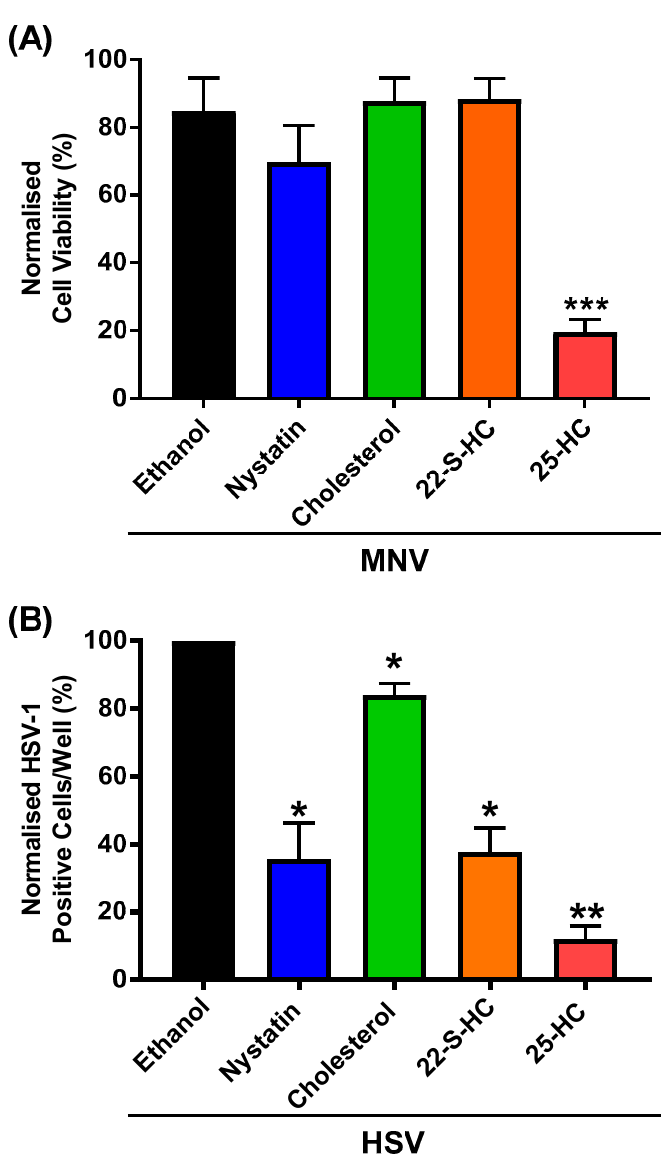
Figure 5. The effect of 25-HC is oxysterol-specific. ( A ) RAW264.7 cells were infected with MNV at 0.05 TCID50/cell in the presence of 25-HC, 22-S-HC, cholesterol (all 6.6 µ M), nystatin (50 µ M) or ethanol-only control. Cell viability was measured by MTS assay 72 h post-infection. Data are expressed as mean percentage cell viability normalized to untreated and uninfected cells ( n = 3 ± SEM, *** = p < 0.001). ( B ) Replicate wells of RAW264.7 cells were infected with HSV-1–GFP at an MOI of 0.03 PFU/cell and treated with 25-HC, 22-S-HC, cholesterol (all 6.6 µ M), nystatin (50 µ M) or ethanol-only control. Cells were incubated for 48 h before GFP expression was quantified using an Incucyte ZOOM FLR. Data show the mean number of HSV-1-positive cells per well normalized to ethanol solvent control and statistical analysis compared to ethanol-only control ( n = 3 ± SEM, * = p < 0.05, ** = p <